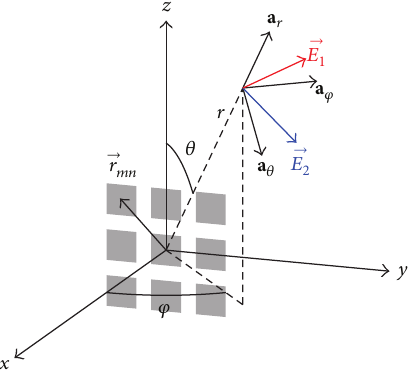
Figure 1: The array configuration and spherical coordinate system used for radiated electric